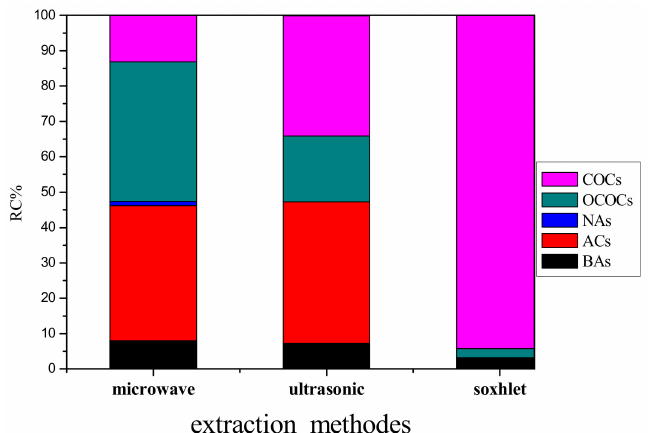
Figure 6. Relative contents (RC) of the extracted substances according to the categories referred